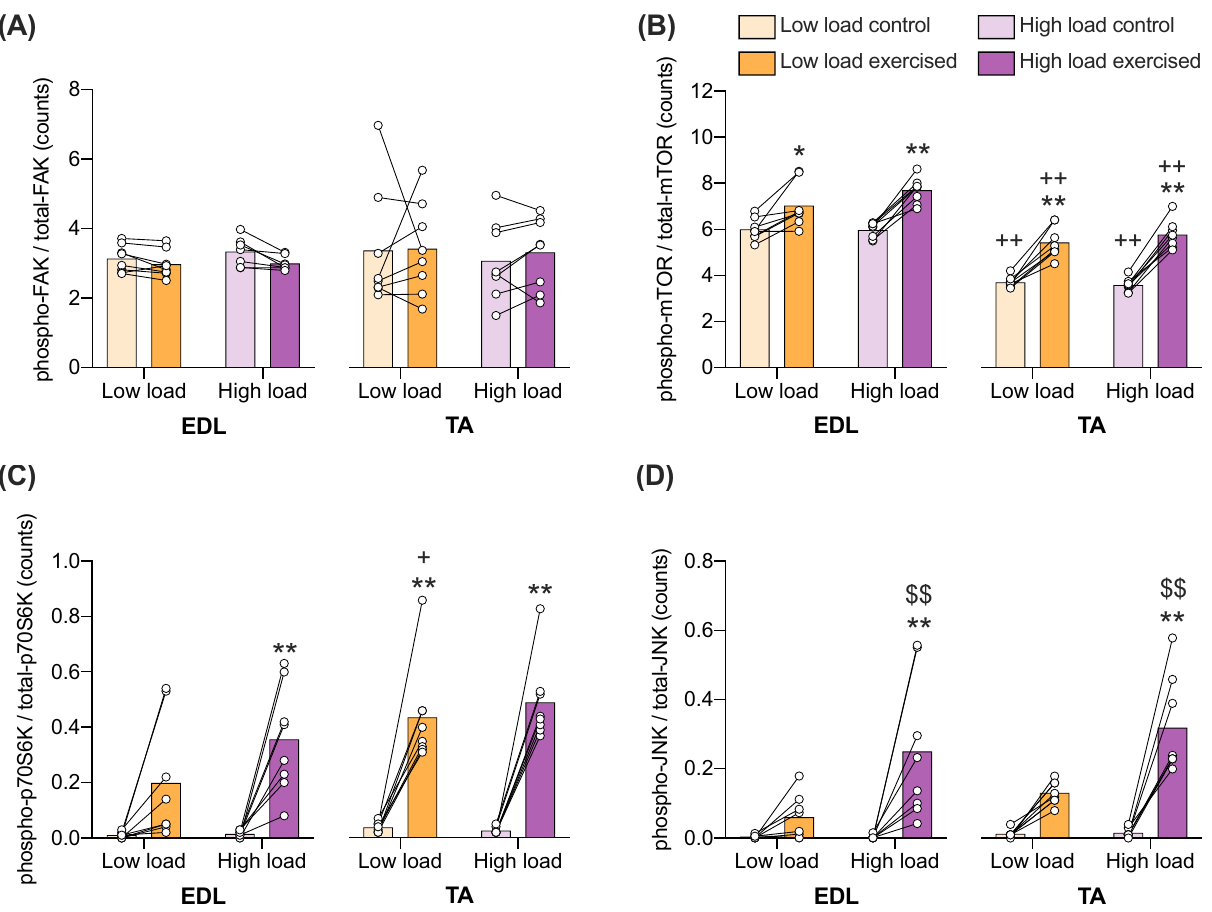
Figure 1. Exercise-induced JNK phosphorylation is load-dependent, while mTOR and p70S6K phosphorylation is muscle-type dependent. Specific phosphorylation (phosphorylated protein / total protein) of Y397-FAK ( a ), pS2448-mTOR ( b ), pT421/S424-p70S6K ( c ), and pT183/Y185-JNK ( d ) as measured in 33 µg soluble protein from exercised and contralateral control TA and EDL muscles after a 28-min exercise stimulus with a high or a low load. Post-hoc significant differences denoted with *, ** p < 0.05 and 0.01 versus control leg; + , ++ p < 0.05 and 0.01 vs EDL within same exercise group; $$ p < 0.01 versus low load exercised group within the same muscle. Data are presented as individual muscle values (circles), contralateral comparisons (lines) and group means (bars) (n = 8 per